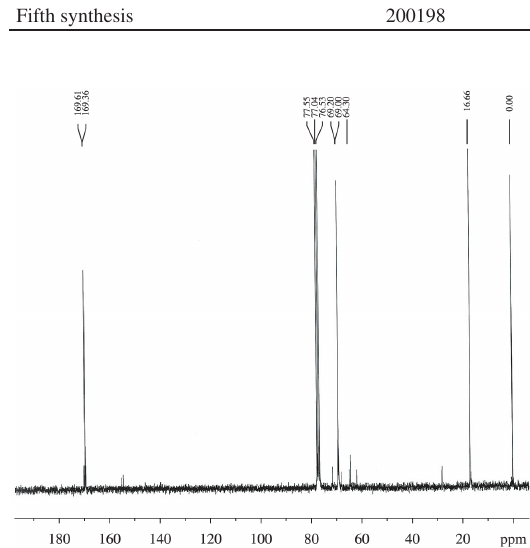
Figure 5. 13 C-NMR spectrum of PLDLA-TMC.